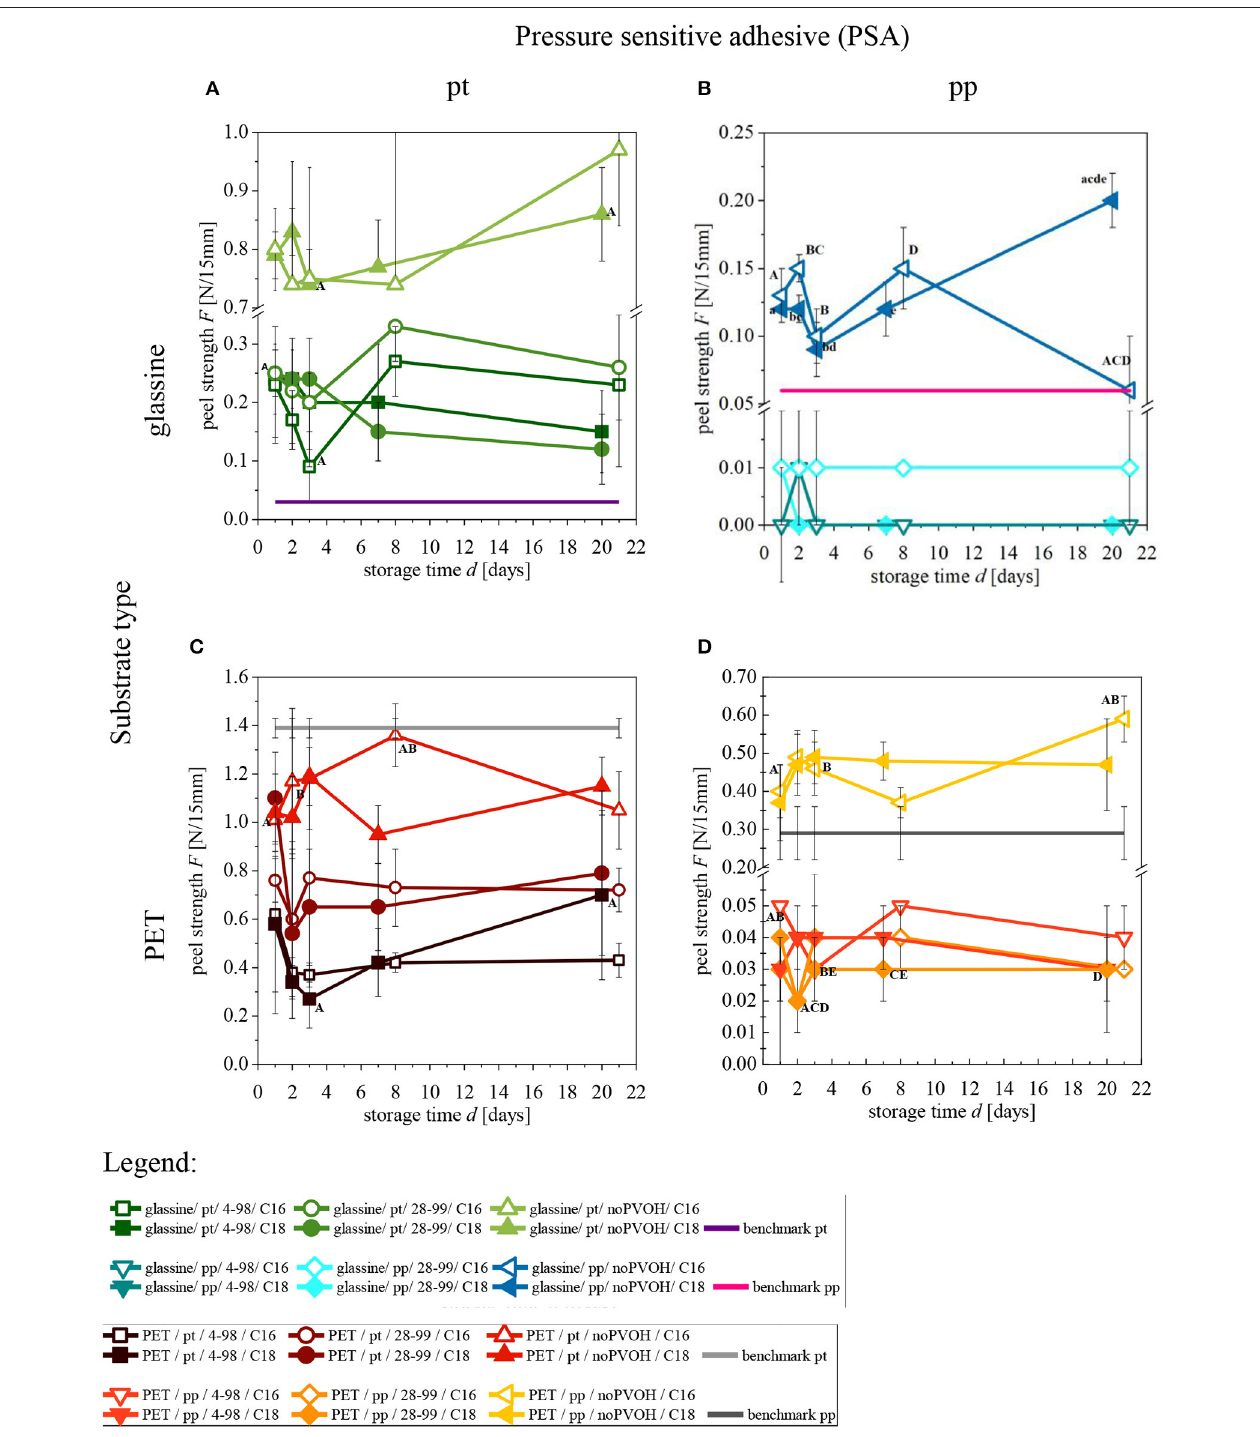
FIGURE 5 | Peel strength of (A) G/pt / PVOH / FA (B) G/pp / PVOH / FA (C) PET / pt / PVOH / FA (D) PET / pp / PVOH / FA over storage time. Same letters indicate statistically significant difference ( p < 0.05, two-sample t -test). Levene-Test and Kolmogorov-Smirnov was carried out. n = 5. Error bars show standard deviations. be explained by the higher viscosity of the PVOH 28-99 PVOH type does not influence the outcome. Concluding, (see also section Influence of Substrate Roughness on the PVOH type only influences peel strength for PSA Peel types with high adhesion ( pt ). In this case, the effect might